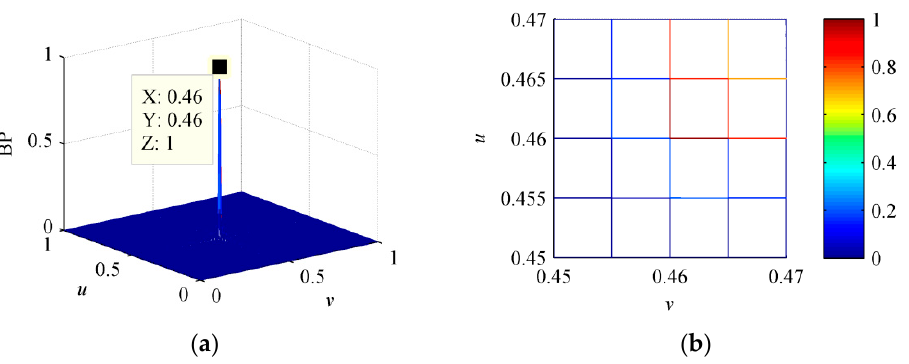
Figure 2. Estimated DOA of CVX method: ( a ) normalized beam pattern; ( b ) estimated DOA O and 5 × 5 surrounding directions.